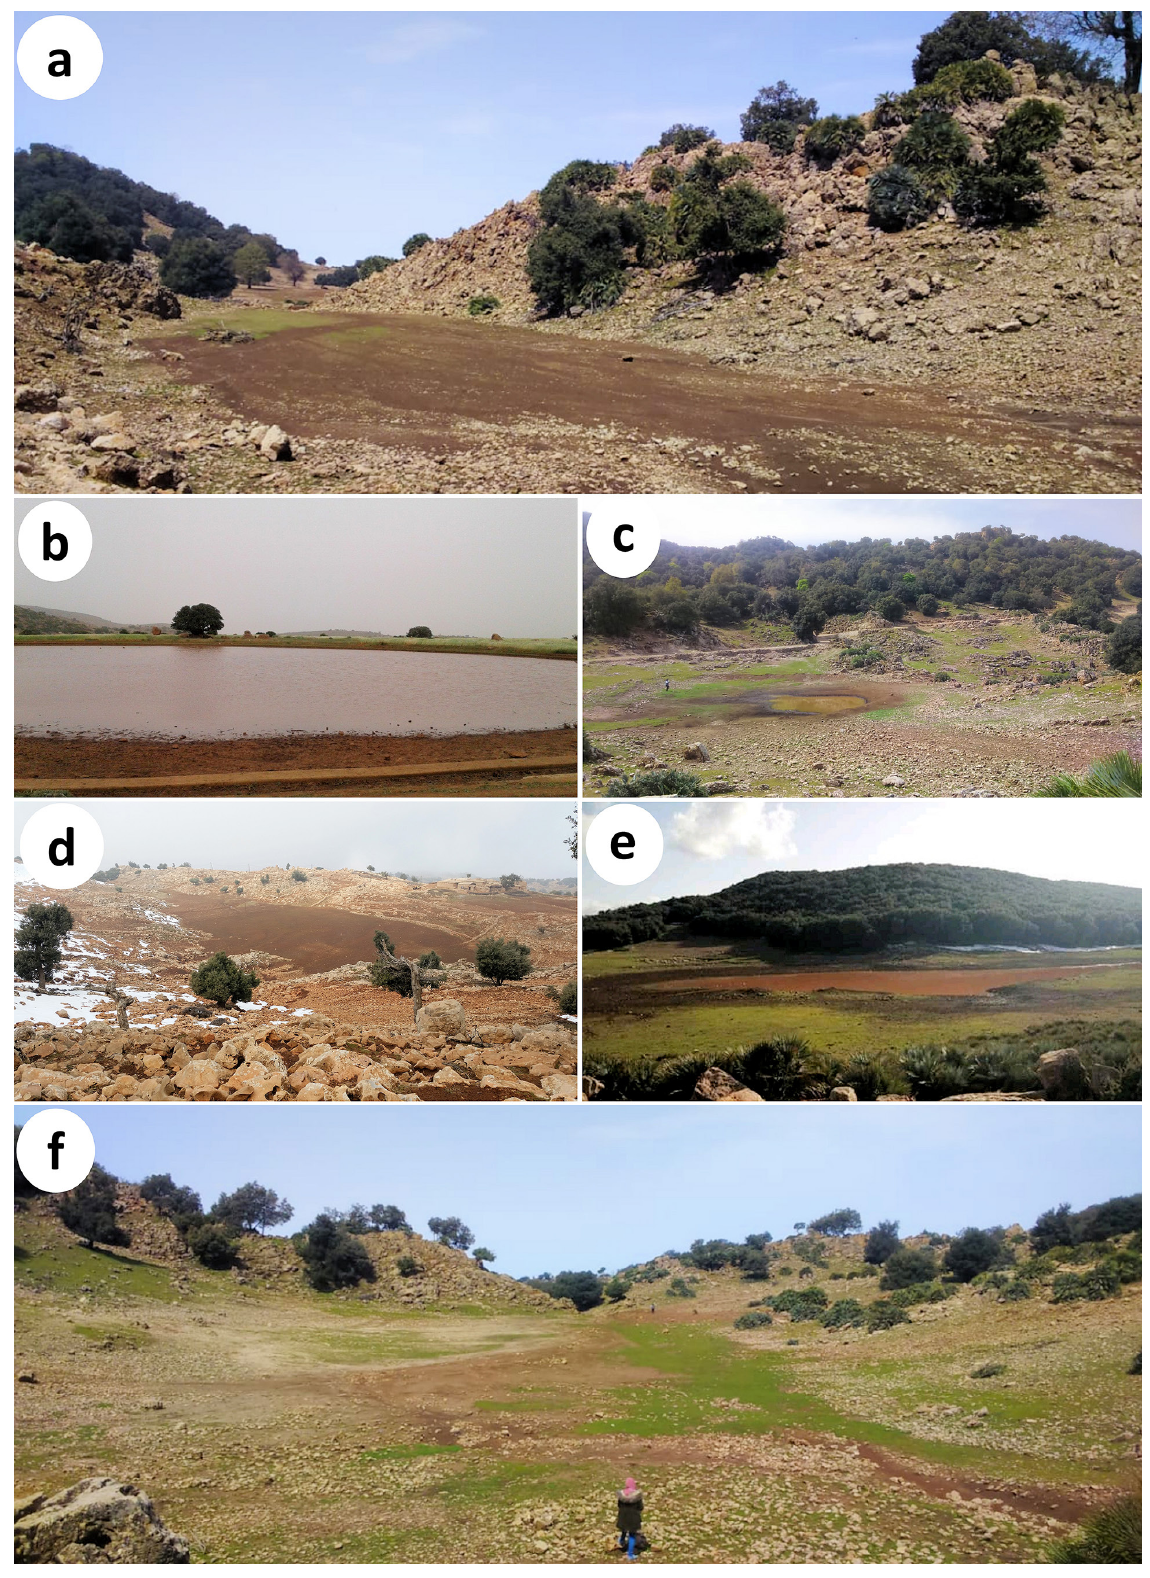
Fig. 6. The important sinkholes in the Study